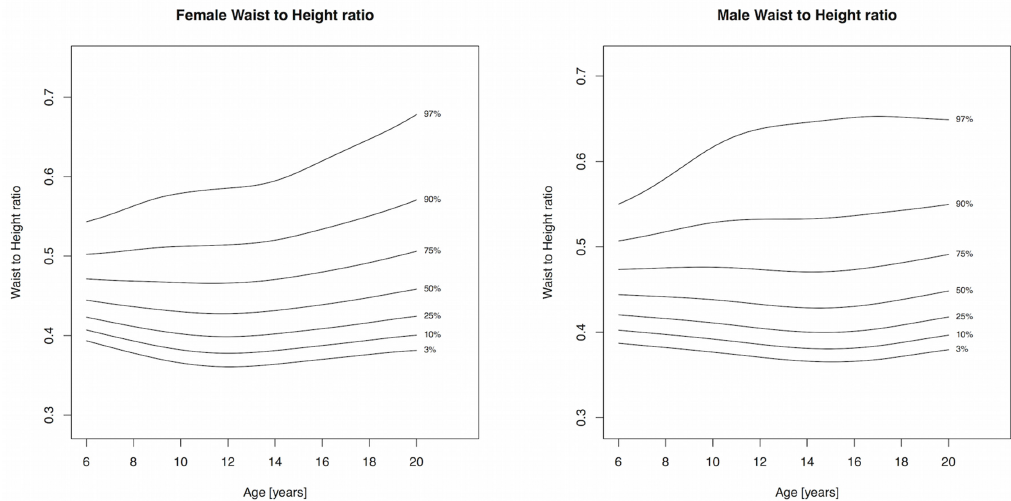
Fig 3. Percentile curves for waist to height ratio for male and female Canadian children and youth aged 6 to 19 years.